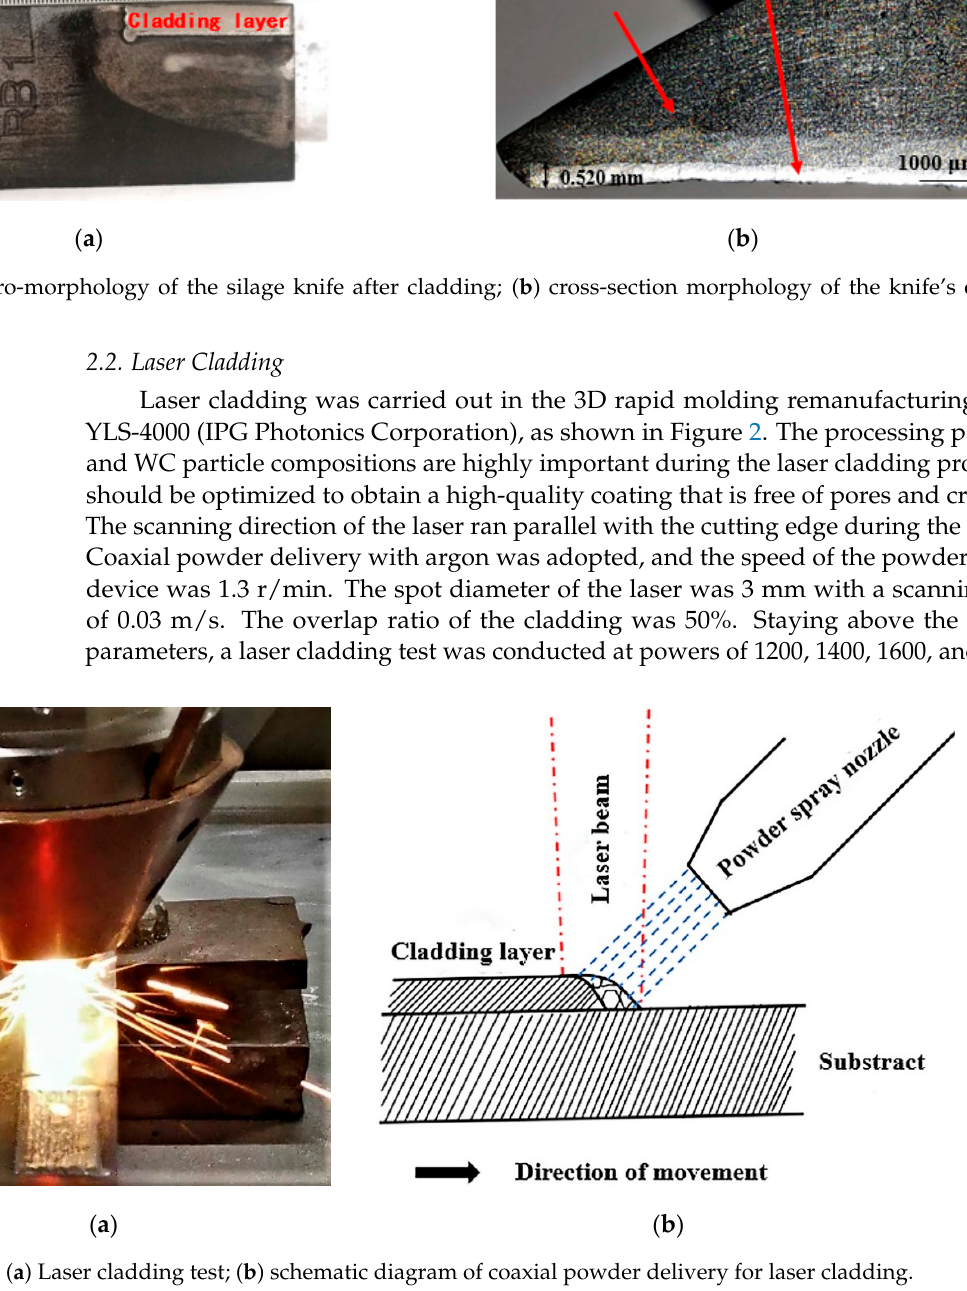
Figure 2. ( a ) Laser cladding test; ( b ) schematic diagram of coaxial powder delivery for laser cladding.